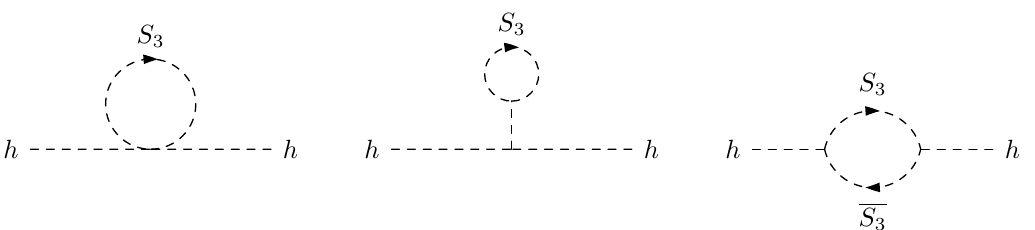
Figure 2 . One-loop Feynman diagrams contributing to the Higgs mass, due to the S 3 leptoquark running in the